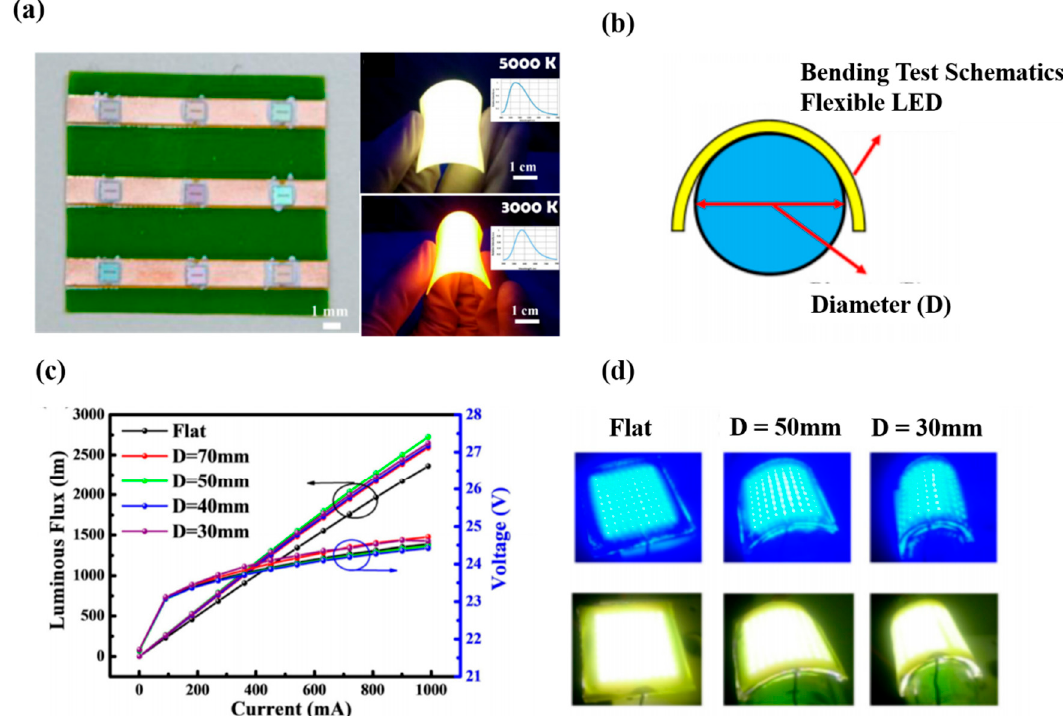
Figure 18. ( a ) LED array under optical microscope (left), phosphor layers at 5000 K and 3000 K (right top and bottom, respectively). ( b ) Schematic of flexible device. ( c ) Voltage and luminous flux with respect to current at different bending diameters for the flexible white LED. ( d ) Top and bottom photographs depict before and after bonding the adhesive phosphor film and blue LED arrays, respectively [85]. Figure reproduced with permission from Optical Society of America.